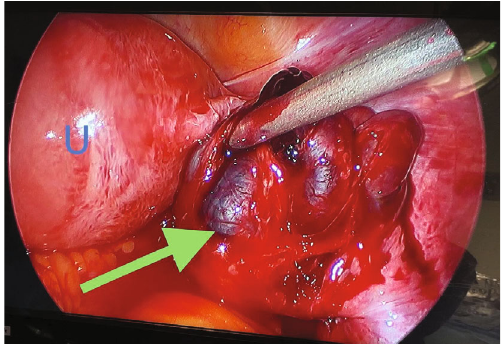
Figure 6: Intraoperative view of an enlarged uterus (U) and enlarged right fallopian tube with hemoperitoneum from the ruptured ectopic gestation (green arrow).